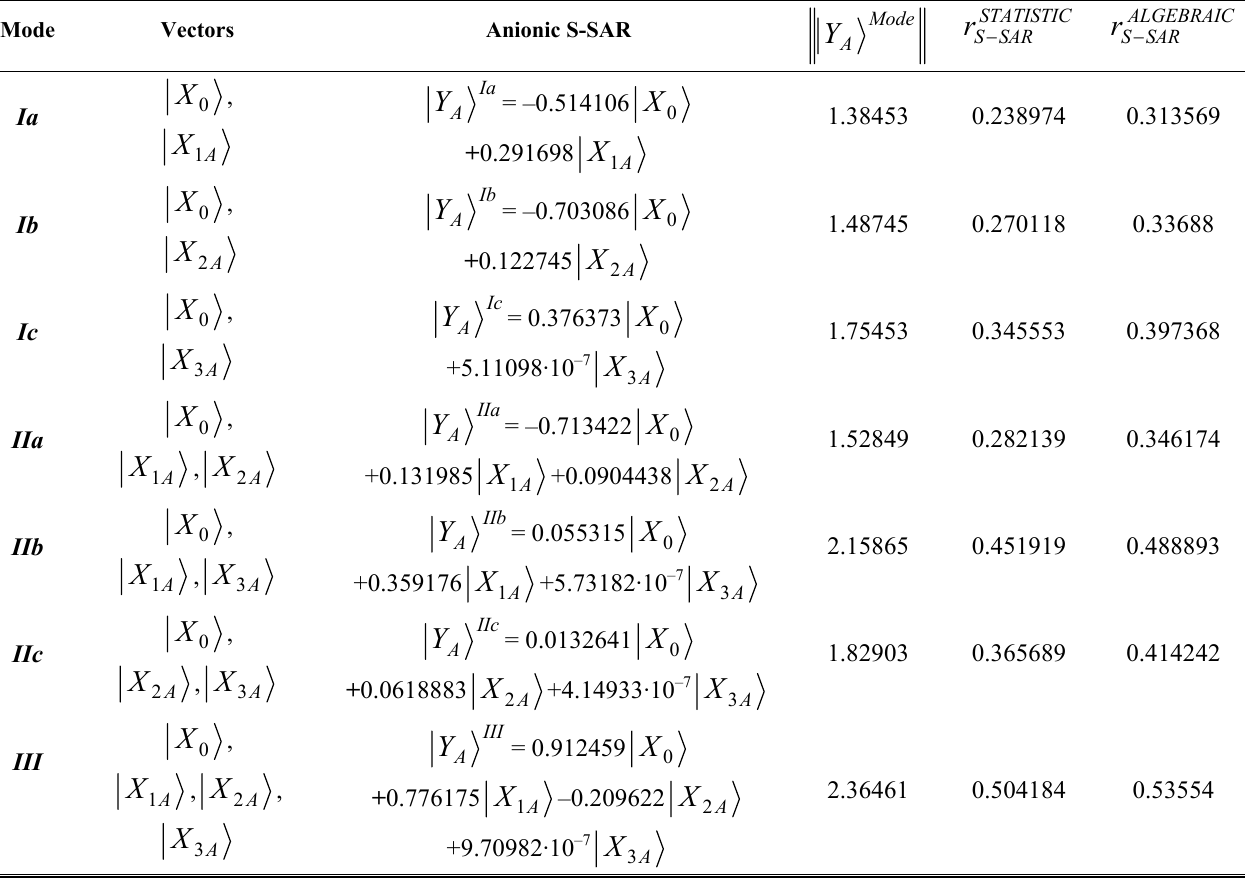
Table 4: Spectral structure activity relationships (S-SAR) of the ionic liquids of Figure 2 against Vibrio fischeri toxicity, and the associated computed spectral norms with ║ | Y and algebraic correlation factors, computed upon the relations (6), (7), and (8), through all possible correlation models considered from the anionic data in Table 2,